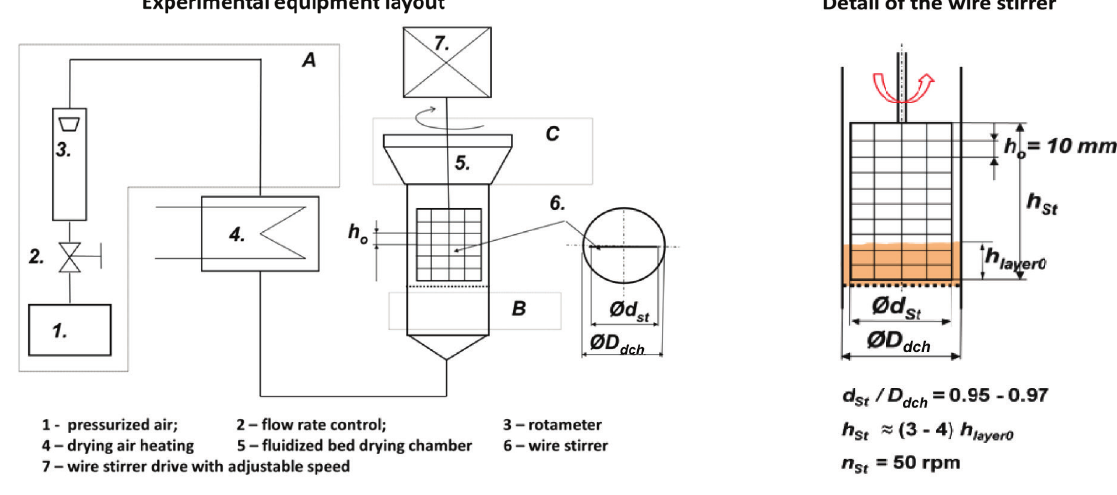
Fig. 2 – Sketch of the experimental dryer (A, B, C = drying air states – see Fig. 4)